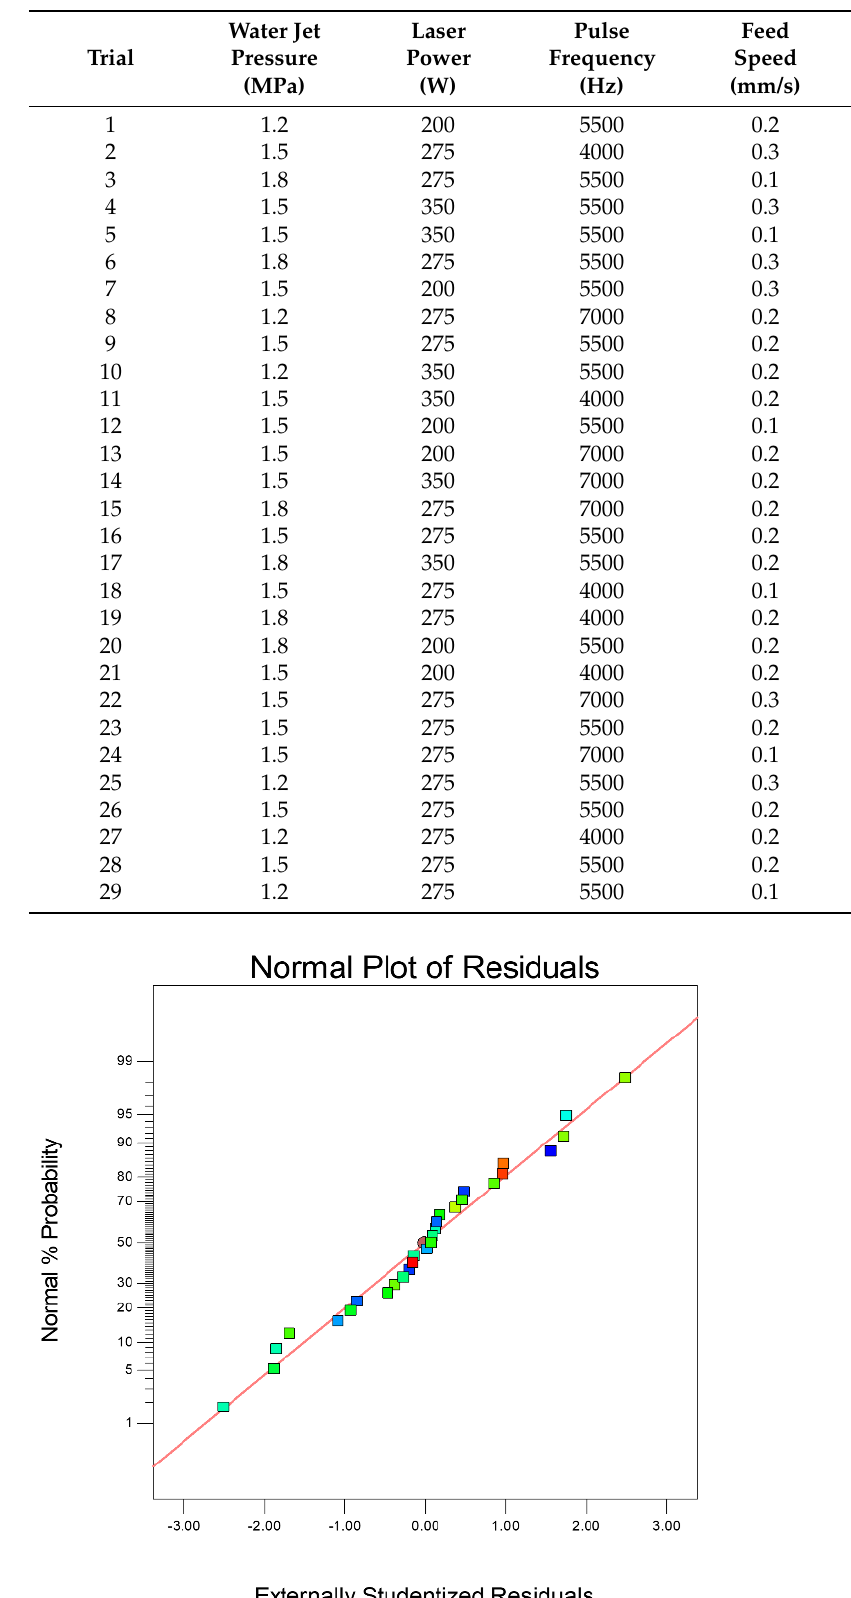
Figure 14. Residual distribution of actual value and predicted value. 4.2.1. Results of the ANOVA for the Model Table 7 shows the results of the ANOVA on the cutting depth prediction model. The table shows that the F value of the model was 26.28 and the value of “Prob > F” ( p -value) was <0.0001, which indicates that the prediction model of the regression equation estab- lished between the cutting depth of and the four independent variables was highly signif- icant and that the prediction model can effectively respond and predict the variation rela- tionship between the cutting depth and the independent variables. The p -value of model “lack of fit” was 0.1524 > 0.05, which indicates that the lack of fit was not significant. The multivariate correlation coefficient “R-squared” value was 0.9633, and the adjusted mul- tivariate correlation coefficient “Adj R-Squared” value was 0.9267, indicating that the pre- diction model explained 92.67% of the response values and had a high accuracy of predic- tion.